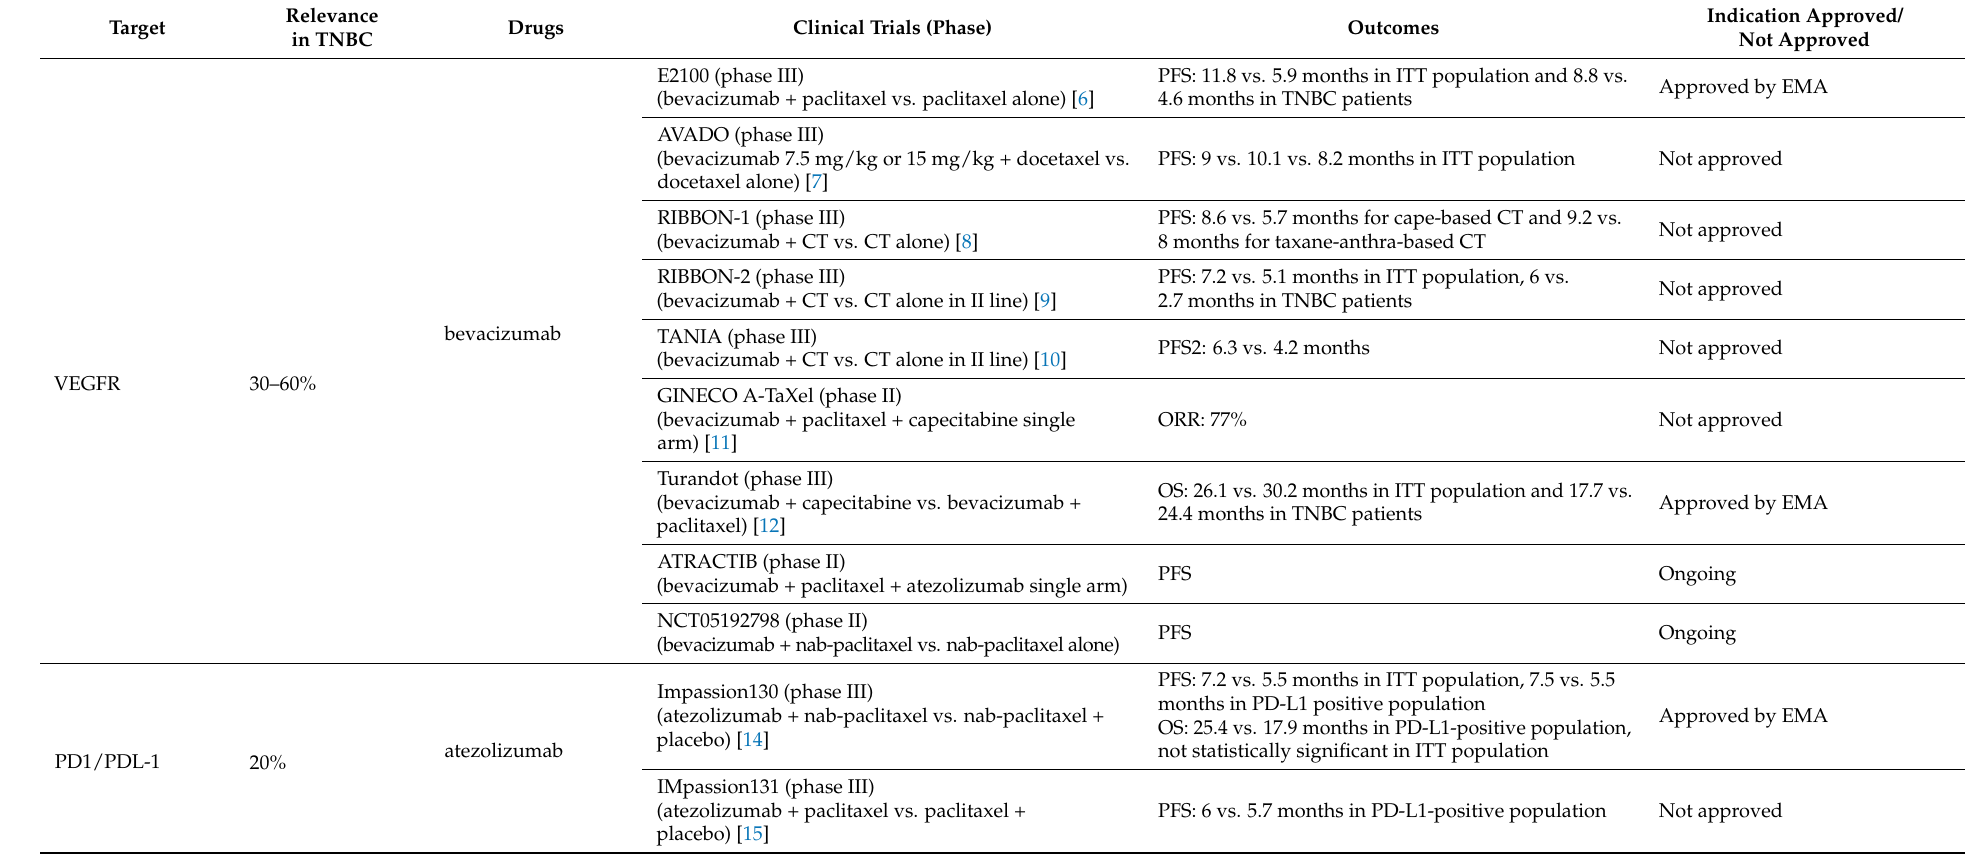
Table 1. Targeting the microenvironment (angiogenesis and the immune system): summary of clinical